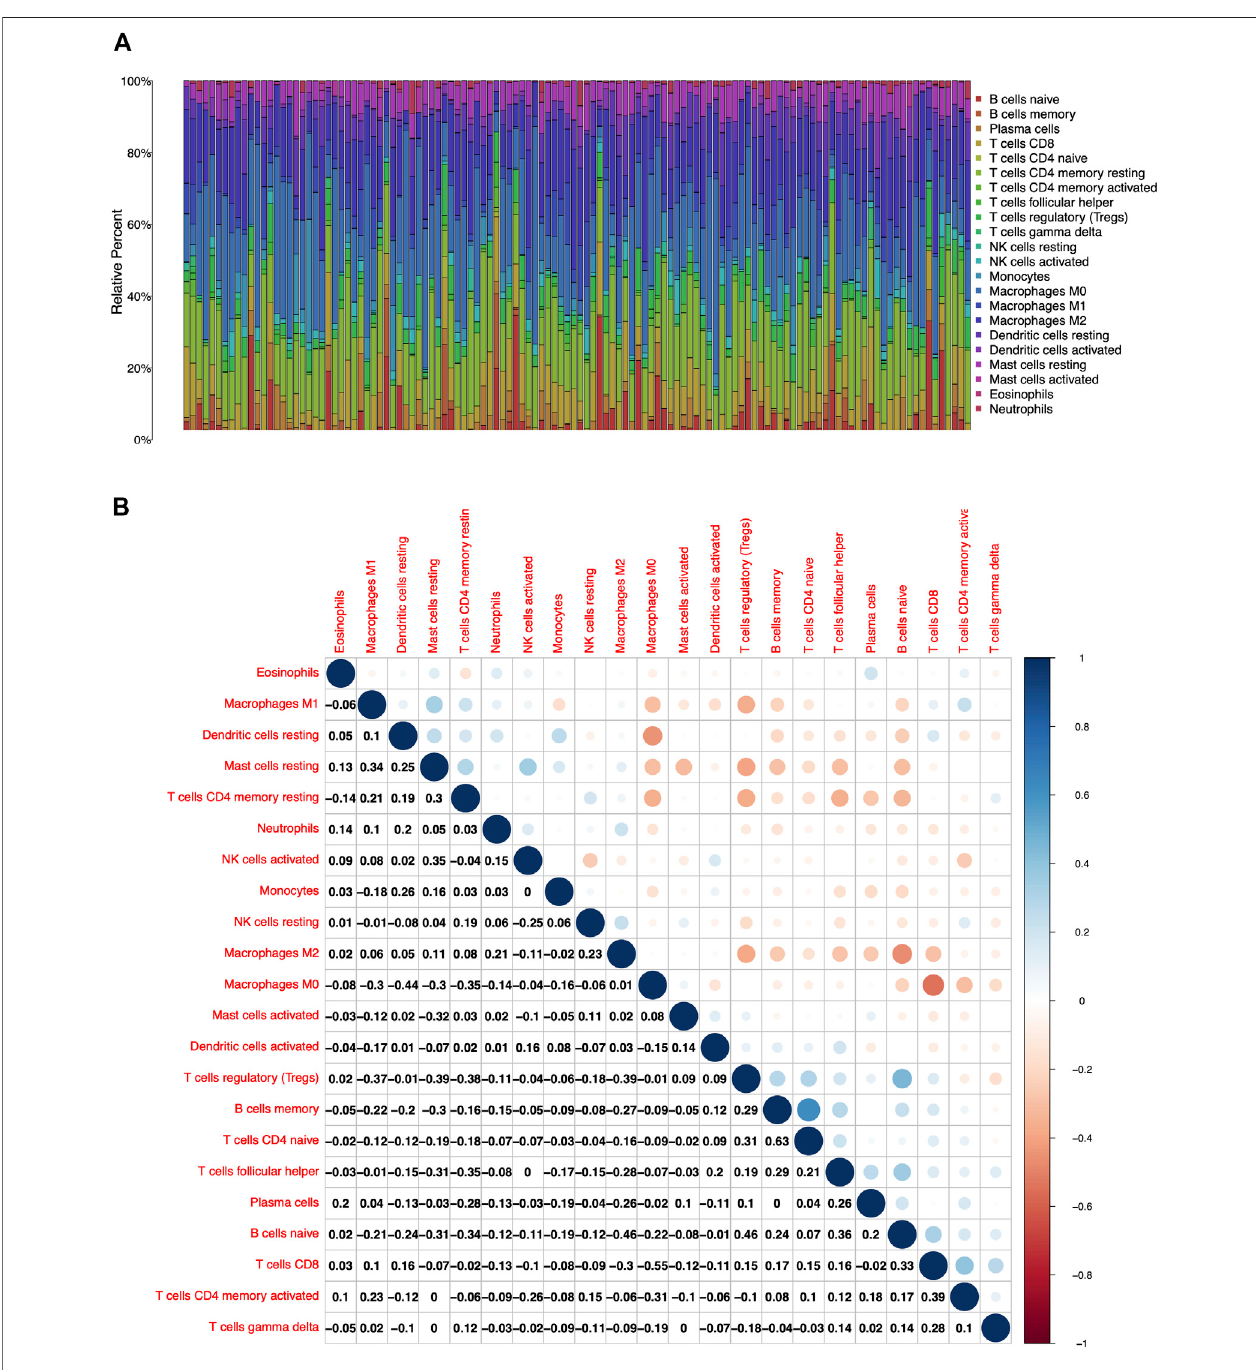
FIGURE 9 | The fractions of tumor in fi ltrated immune cells in PAAD and correlation analysis with CIBERSORT. (A) The fractions of 22 kinds of tumor in fi ltrated immune cells in PAAD. (B) Correlation with 22 kinds of tumor in fi ltrated immune cells. The number and the size of circle in each tiny box on behalf of correlation value between corresponding two cells by Pearson coef fi cient